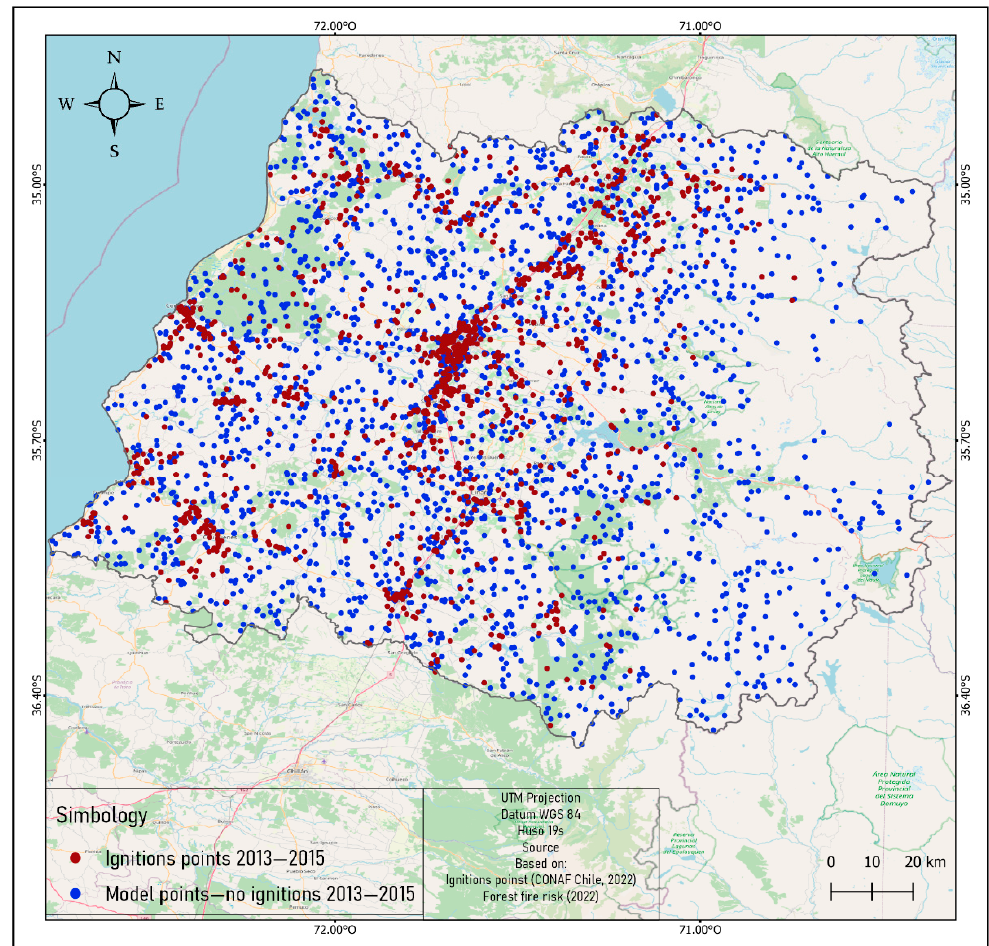
Figure 2. Binary dependent variable, ignition of wildland fires in the Maule region between the years 2013 to 2015.